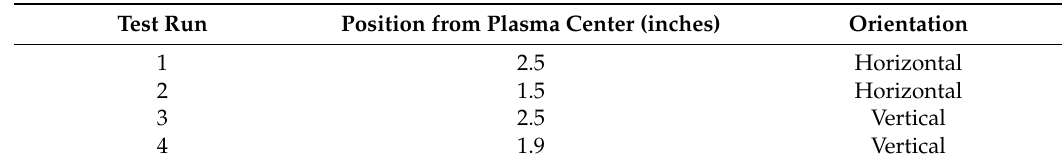
Table 1. The positions and orientations of the solar panel. Test Run Position from Plasma Center (inches) Orientation 1 2.5 Horizontal 2 1.5 Horizontal 3 2.5 Vertical 4 1.9